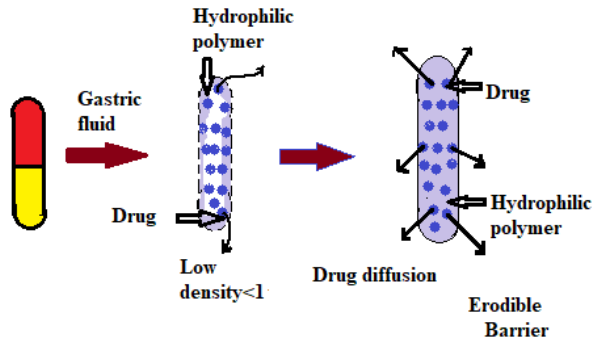
Fig. 3. Representation of hydrodynamically